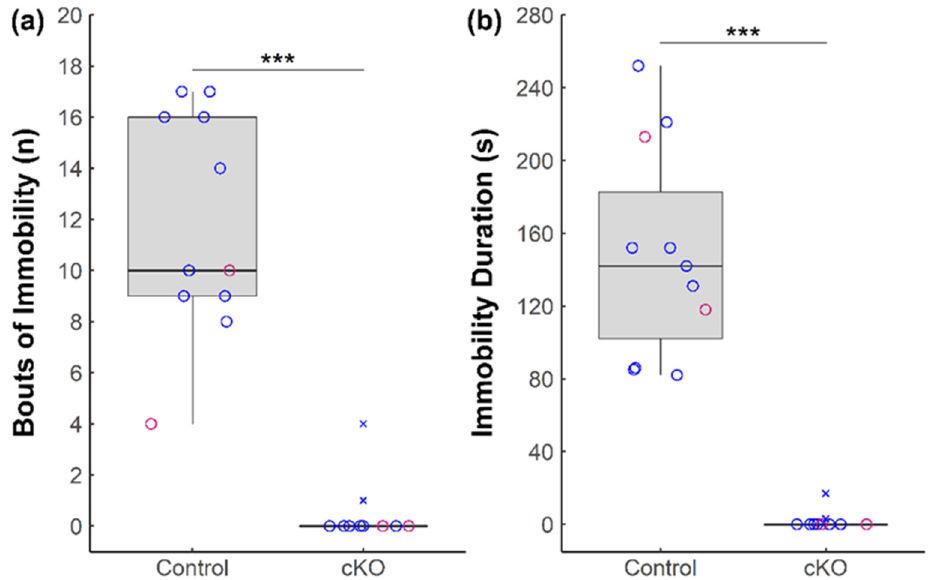
Figure 2. Behavioral effects of Sox2 ablation in the SCN during the tail suspension test. ( a ) Total bouts of immobility and ( b ) duration of immobility of Sox2 cKO mice ( n = 10) and littermate controls ( n = 11) during the tail suspension test. Female mice are denoted in pink and male mice are denoted in blue. Outliers are denoted by cross marks. Statistical significance from Wilcoxon rank-sum tests is marked with *** ( p < 0.001).